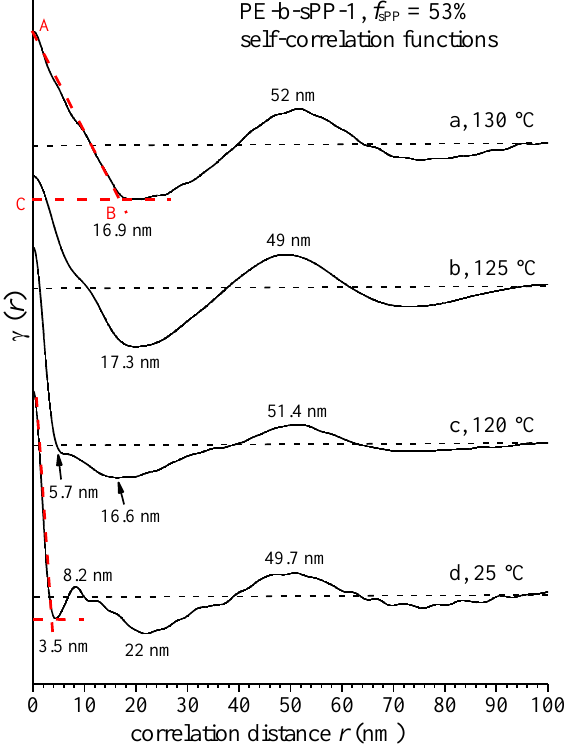
Figure 7. Normalized self-correlation functions of electron density fluctuations γ ( r ) calculated from the SAXS intensities of the sample PE-b-sPP-1 with f sPP = 53% of Figure 5, recorded at different temperatures (a–d) during cooling from the melt. The main correlation triangle ABC, and the average values of periodicity L , and of thicknesses of crystalline or amorphous layers of the layer structure of Figures 6C and 8, are indicated.